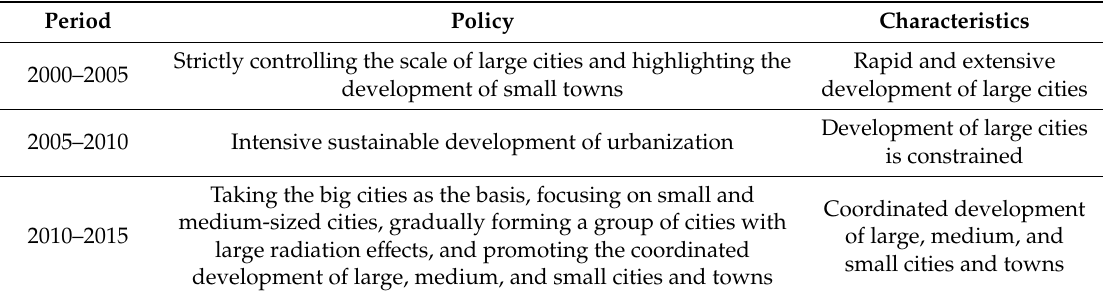
Table 2. The policies and characteristics of urban development during di ff erent periods. Period Policy